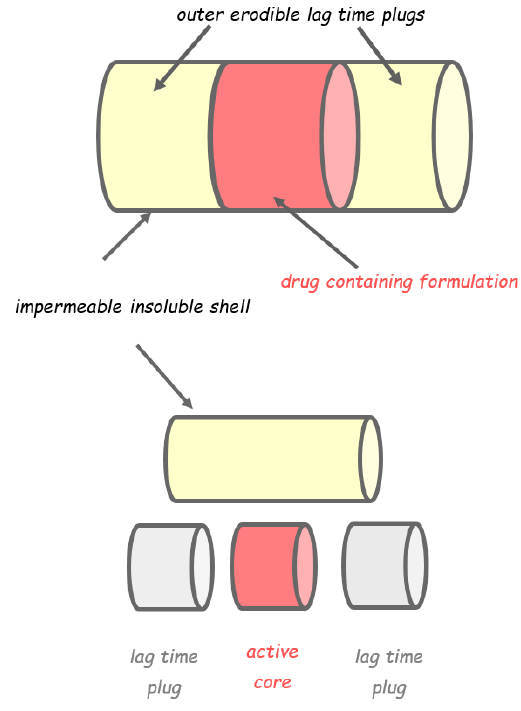
Figure 11. Schematic representation of the Egalet ® system. Adapted from Ref. [49].